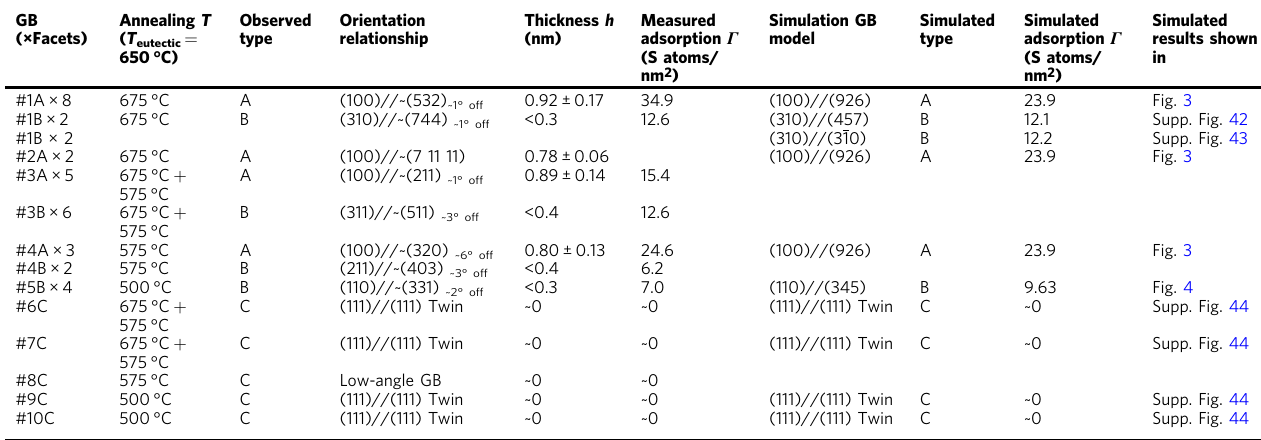
Table 1 Summary of experimental observations and comparisons with simulated results. Grain boundaries were extracted and analysed from seven different